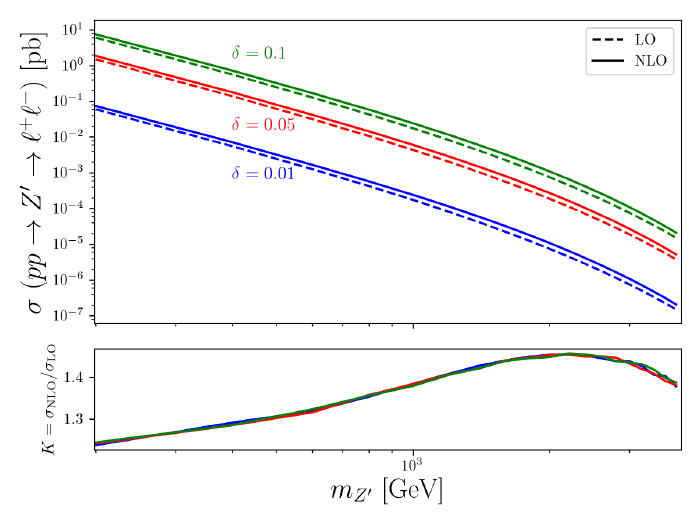
Figure 8 . The LHC production cross section of a Stueckelberg Z 0 as a function of m Z 0 in the √ dilepton channel at s = 14 TeV. The cross section is calculated at LO and NLO for three values of the kinetic mixing δ . The K factor is shown in the bottom